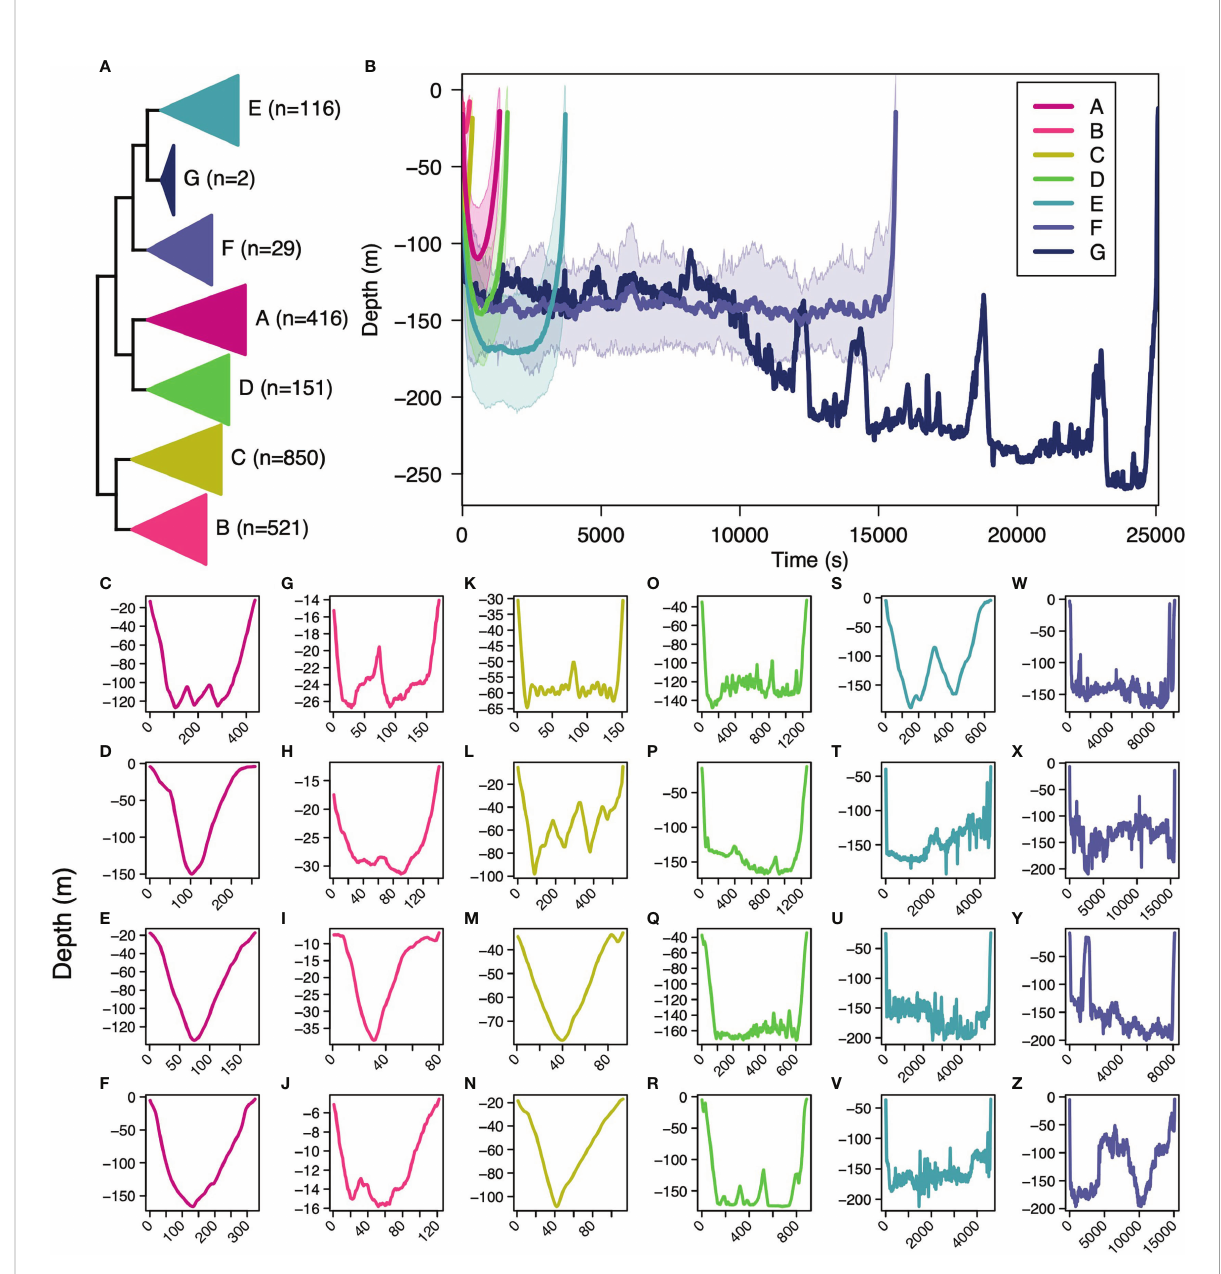
FIGURE 2 The hierarchical clustering between basking shark subsurface movements and number of subsurface movements per cluster (A) , the dissimilarity-weighted mean shape for each cluster (B) , and a random subsample of movements for cluster A (C – F) , for cluster B (G – J) , for cluster C (K – N) , for cluster D (O – R) , for cluster E (S – V) , and for cluster F (W – Z) . The shaded region around the weighted mean shape for each cluster (B) represents one standard deviation around the